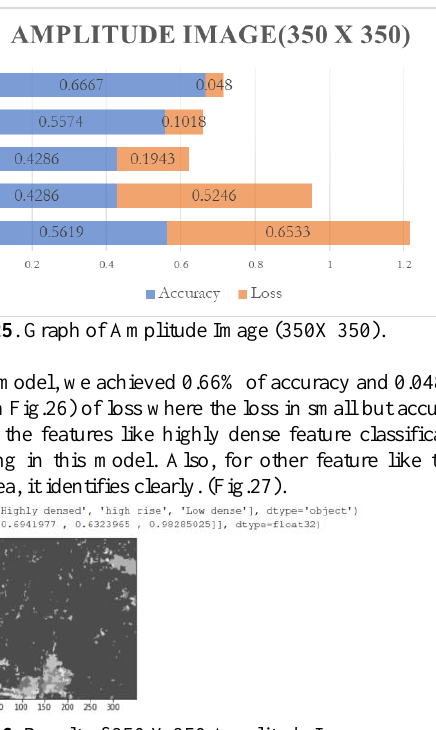
Table 8 . Fused Image Window Size (350 X 350) Used for the Training of Model